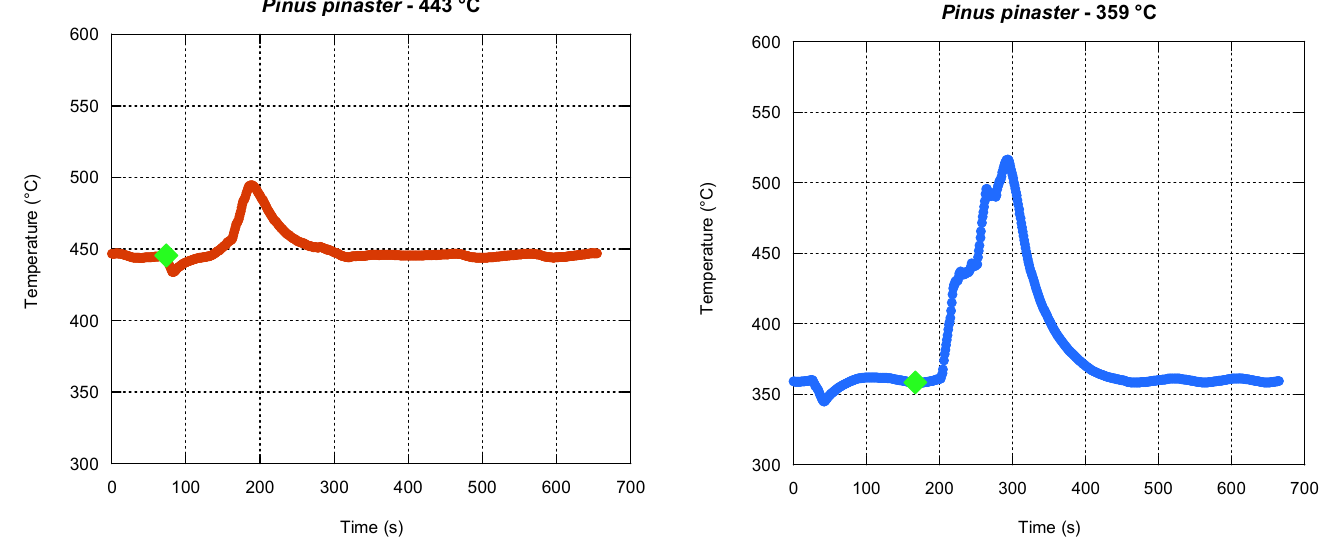
Figure 6. Furnace temperature evolution during tests performed with Pinus pinaster pellets. The green square indicates the ignition moment.